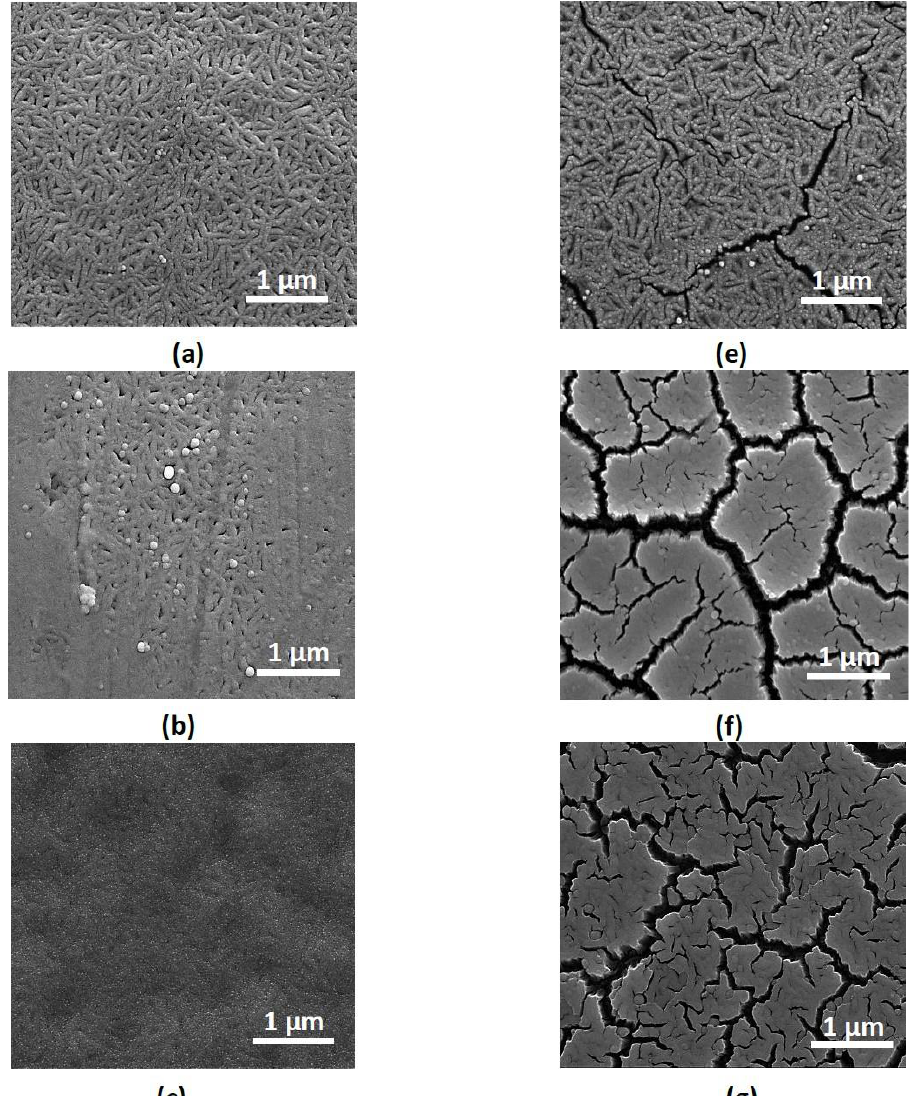
Figure 3. Cont . Figure 3.